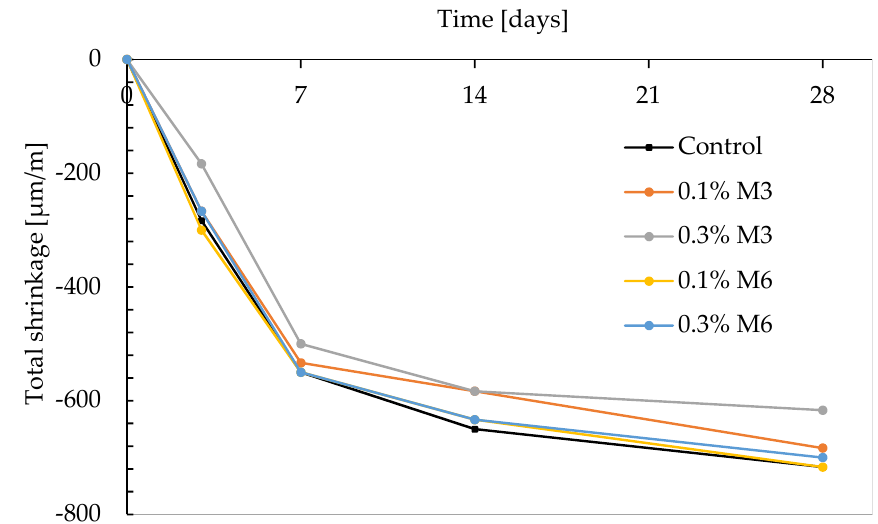
Figure 7. Total shrinkage of mixtures with and without the addition of fibers ( n = 3).